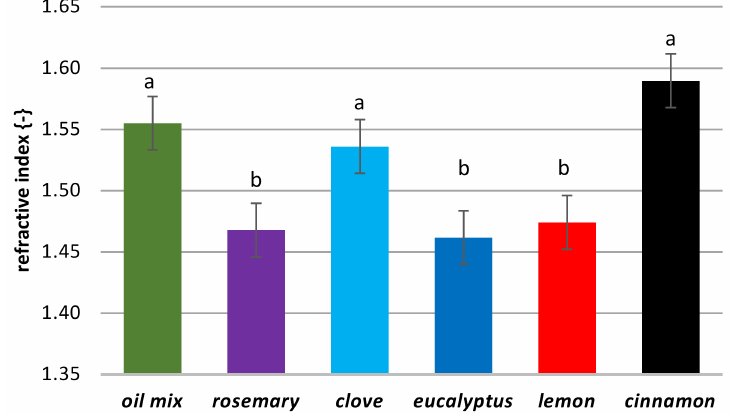
Figure 6. Refractive index of the oils. The different small letters indicate groups of the results that differ statistically